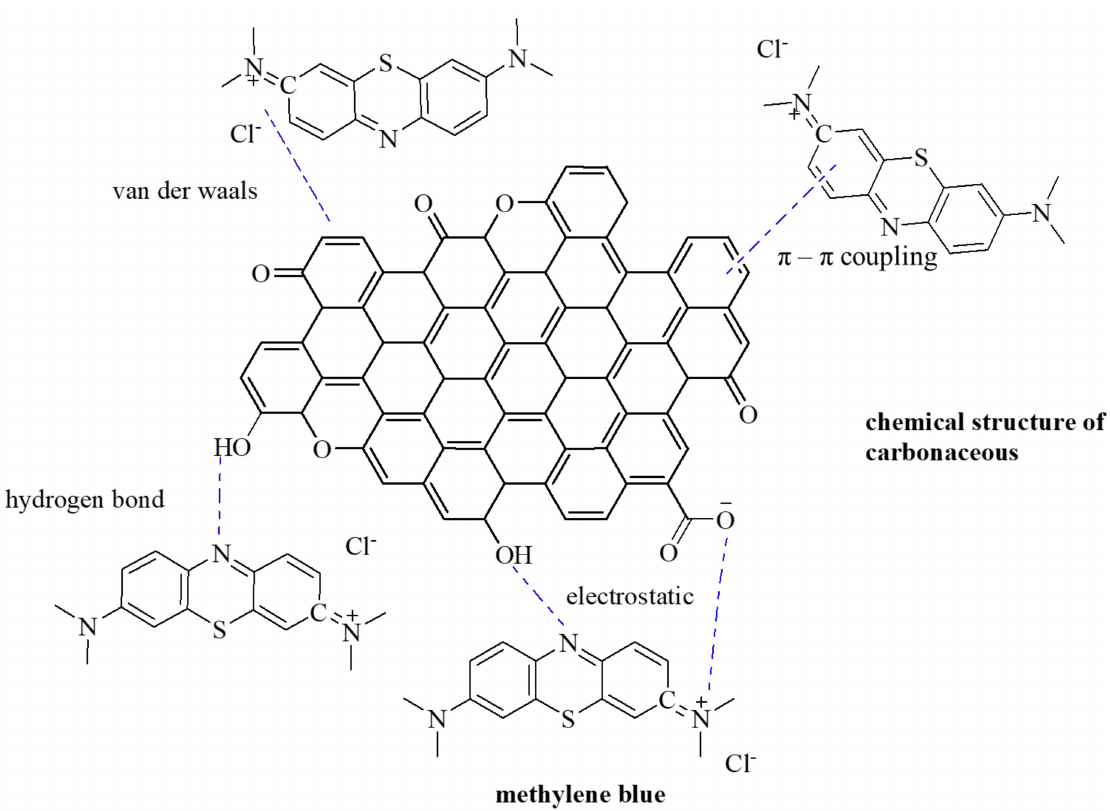
Figure 9. Scheme of the proposed-interaction between carbonaceous surface and methylene